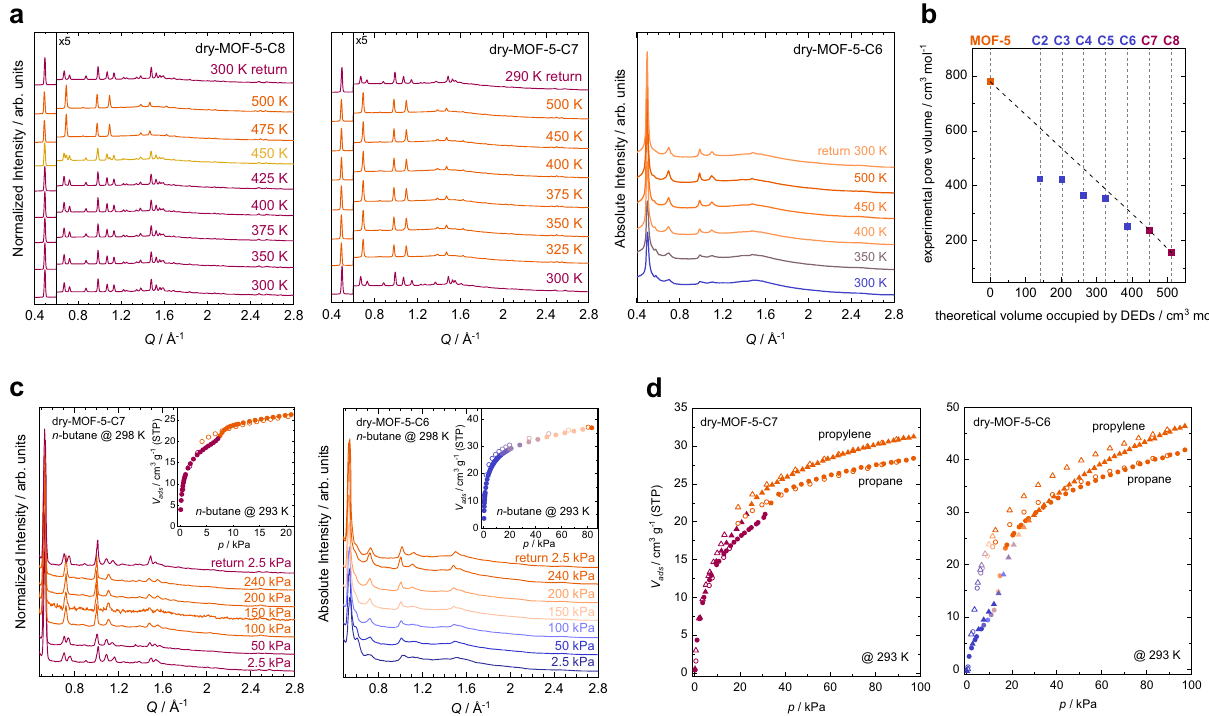
Fig. 5 Thermal and gas sorption properties of MOF-5-CX. a Variable temperature (VT-)PXRD data of dry-MOF-5-C8 to dry-MOF-5-C6. b Plot of the experimental pore volumes (CO 2 ) vs. the theoretical volume occupied by DEDs in dry-MOF-5-CX. The dashed line signi fi es the expected pore volumes obtained by linear interpolation from MOF-5 to dry-MOF-5-C8. c In situ PXRD data during n -butane sorption and associated n -butane sorption isotherms (inlet) of dry-MOF-5-C7 and dry-MOF-5-C6. d Propane and propylene isotherms of dry-MOF-5-C7 and dry-MOF-5-C6 recorded at 293 K. Adsorption and desorption branches are shown as closed and open symbols,